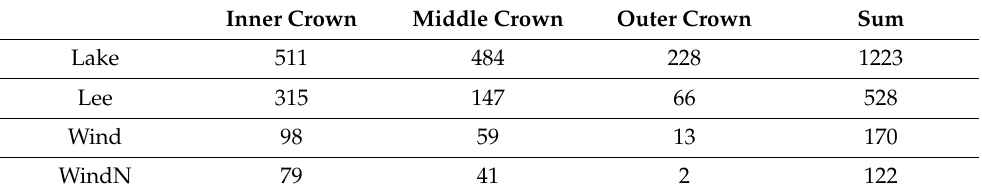
Table 3. Epiphyte abundance within crown locations at the four sites. Inner Crown